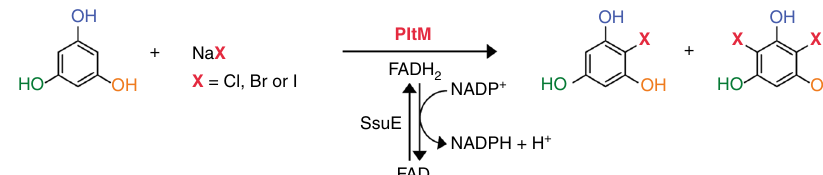
Fig. 1 Halogenation by PltM. Schematic representation of phloroglucinol ( 1 ) halogenation by